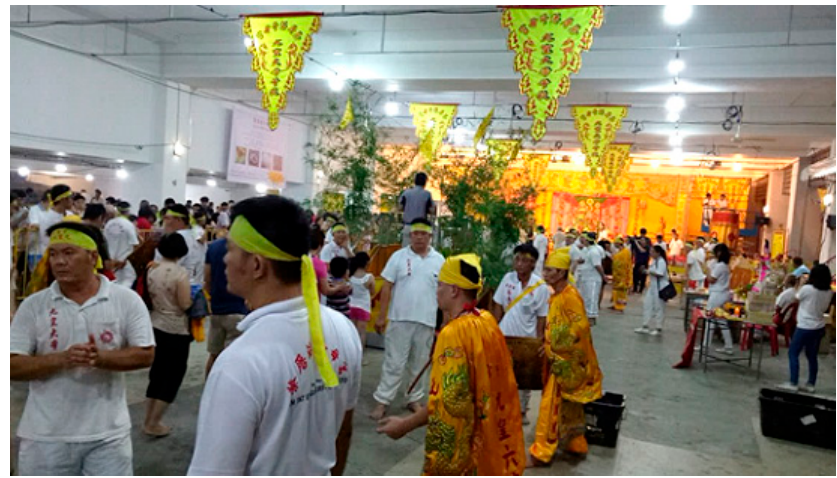
Figure 11. Devotees queue to cross the Bridge of Safe Deliverance.